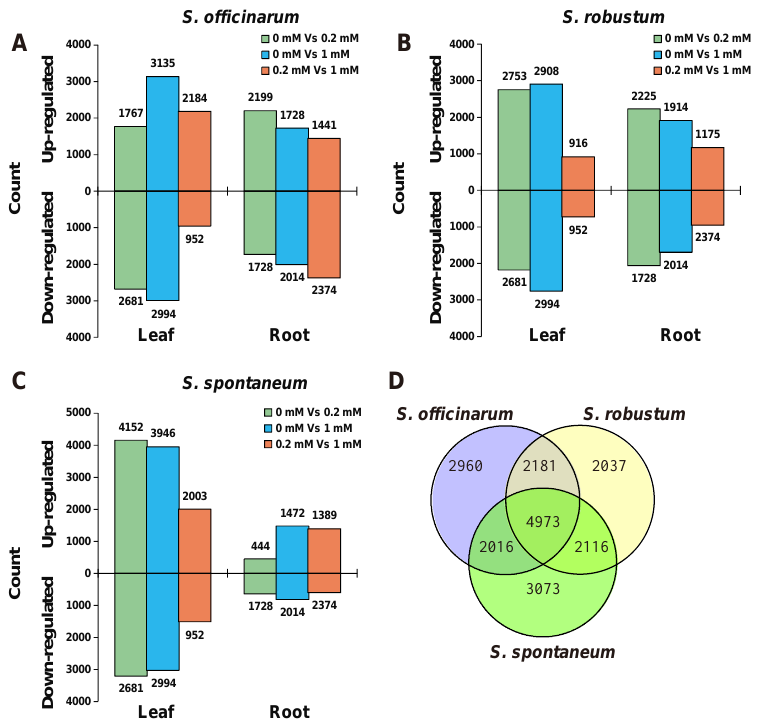
Figure 2. Differential gene expression analysis under three Mg concentration treatments of three Saccharum species. ( A – C ) Up- and down-regulated DEGs determined by the comparison of 0 mM vs. 0.2 mM and 1 mM in the leaf and root of three Saccharum species; ( D ) Venn diagrams showing unique and shared DEGs in three Saccharum